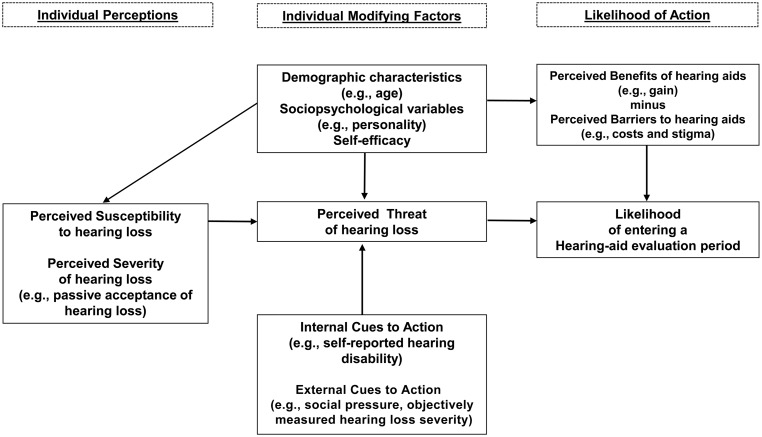
Schematic representation of constructs of the Health Belief Model along with examples of possible predictors of entering a hearing aid evaluation period. Adapted from Strecher and Rosenstock (1997).